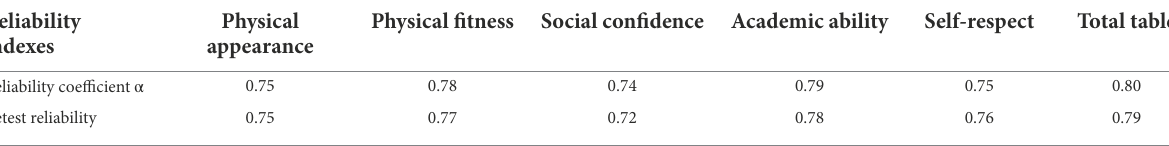
TABLE 3 Reliability indexes of college students’ sense of inferiority scale.